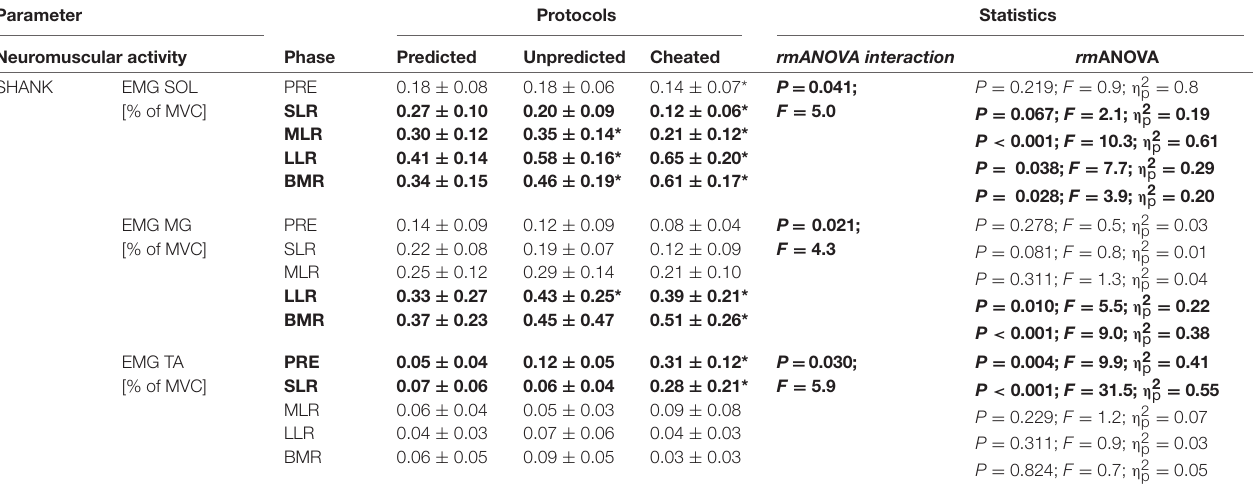
TABLE 2 | Neuromuscular parameters; grand means of EMG integrals during pre-activation (PRE, − 100 to 0ms), the reflex phases SLR, MLR, LLR, and the BMR (120 ms–individual peak of COP) after perturbation, for the muscle groups encompassing the ankle joint (SOL, soleus; MG, medial gastrocnemius; TA, tibialis anterior) are displayed.